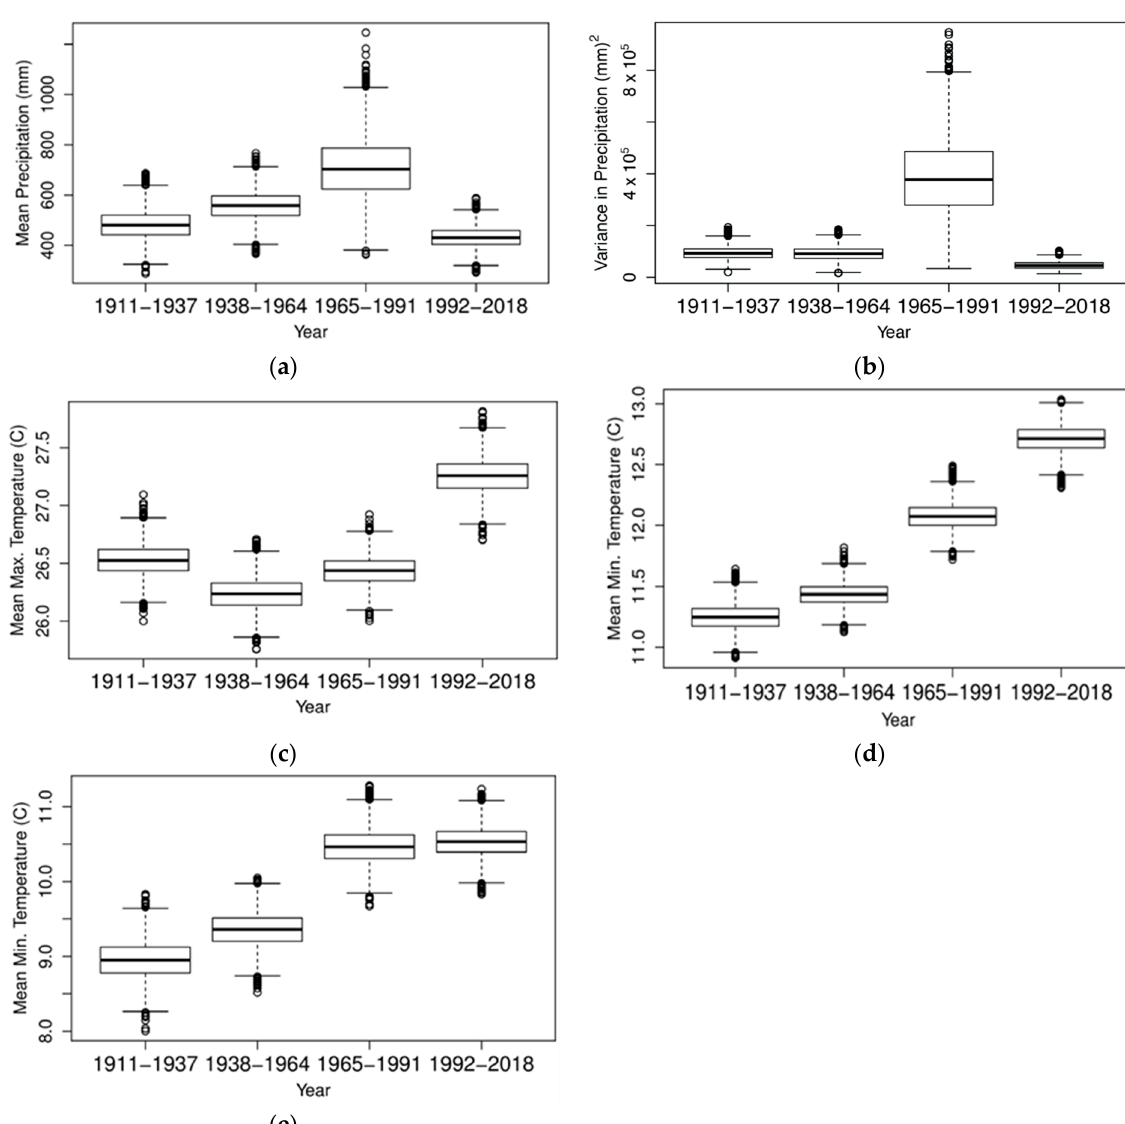
Figure 5. Box and whisker plots of NMDB precipitation, TMax and TMin . Box and whisker plots of NMDB for, ( a ) mean April–May precipitation, and ( b ) variance; ( c ) mean annual TMax; ( d ) mean annual TMin; ( e ) mean April–May TMin.